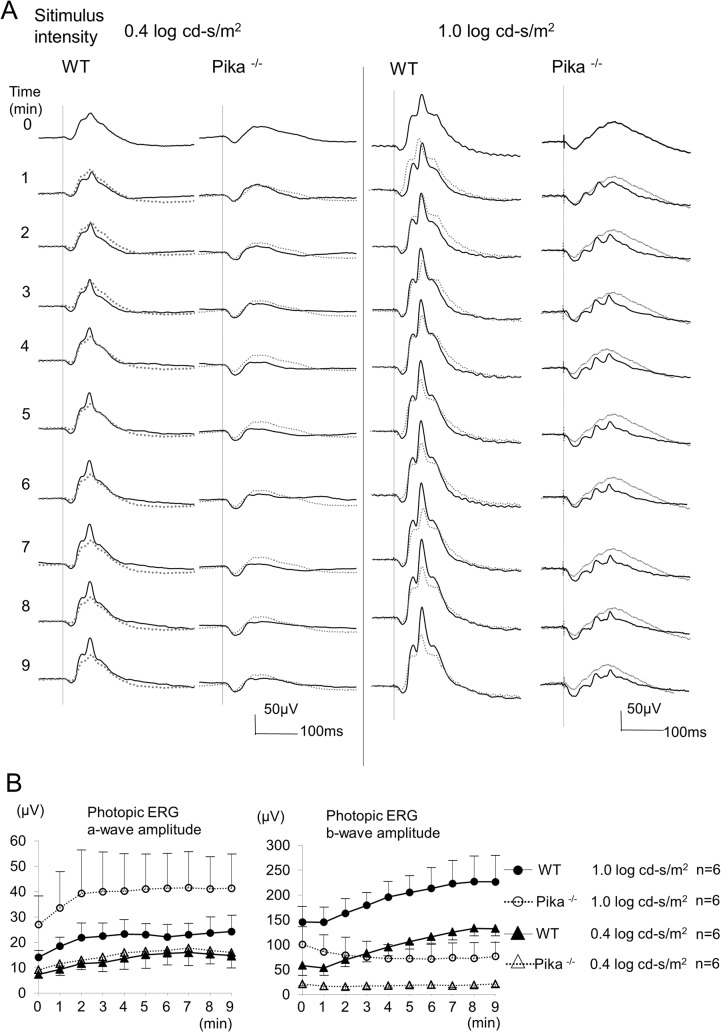
ERGs of wild type (WT) and Pika-/- mice during the light adaptation.(A) Photopic ERGs recorded at each minute for 9 minutes of light adaption (40 cd/m2) from a representative WT mouse and a Pika-/- mouse. ERGs were elicited by two different stimulus intensities, 0.4 and 1.0 log cd-s/m2. ERGs recorded at each minute for 9 minutes of light adaptation (black trace) are superimposed on the ERG elicited at the start of light adaptation (0 min). (B) Time-response curves of the mean a- and b-wave amplitudes of 5 WT mice and 5 Pika-/- mice are shown in the right and left panel respectively. The amplitudes of the photopic a- and b-waves during light-adaptation of WT mice were significantly different from that of Pika-/- mice (P <0.05: repeated measures ANOVA). ● = ERGs of WT mice recorded with 1.0 log cd-s/m2. ○ = ERGs of Pika-/- mice recorded with 1.0 log cd-s/m2. ▲ = ERGs of WT mice recorded with 0.4 log cd-s/m2. △ = ERGs of Pika-/- mice recorded with 0.4 log cd-s/m2. The means ± SDs are plotted.